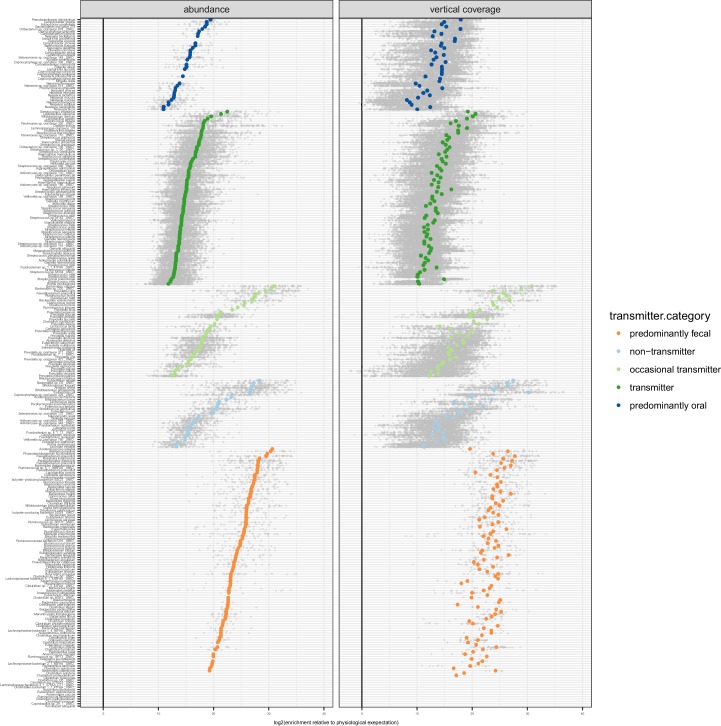
Enrichment of oral species in the gut.Relative to physiologically expected levels of ‘passive’ transmission (see Figure 1C), all tested species with paired observations (in saliva and stool of the same individual) showed a fecal enrichment by several orders of magnitude. The fecal enrichment (x axis) is shown on a log2 scale, so values approximate the effective number of cell divisions (without cell deaths) necessary to account for observed fecal levels based on matched oral samples. The left plot shows enrichment purely based on relative salivary and fecal abundance. On the right, the average oral and fecal depths of uniquely mapping reads is used as a reference, normalised by genome size.